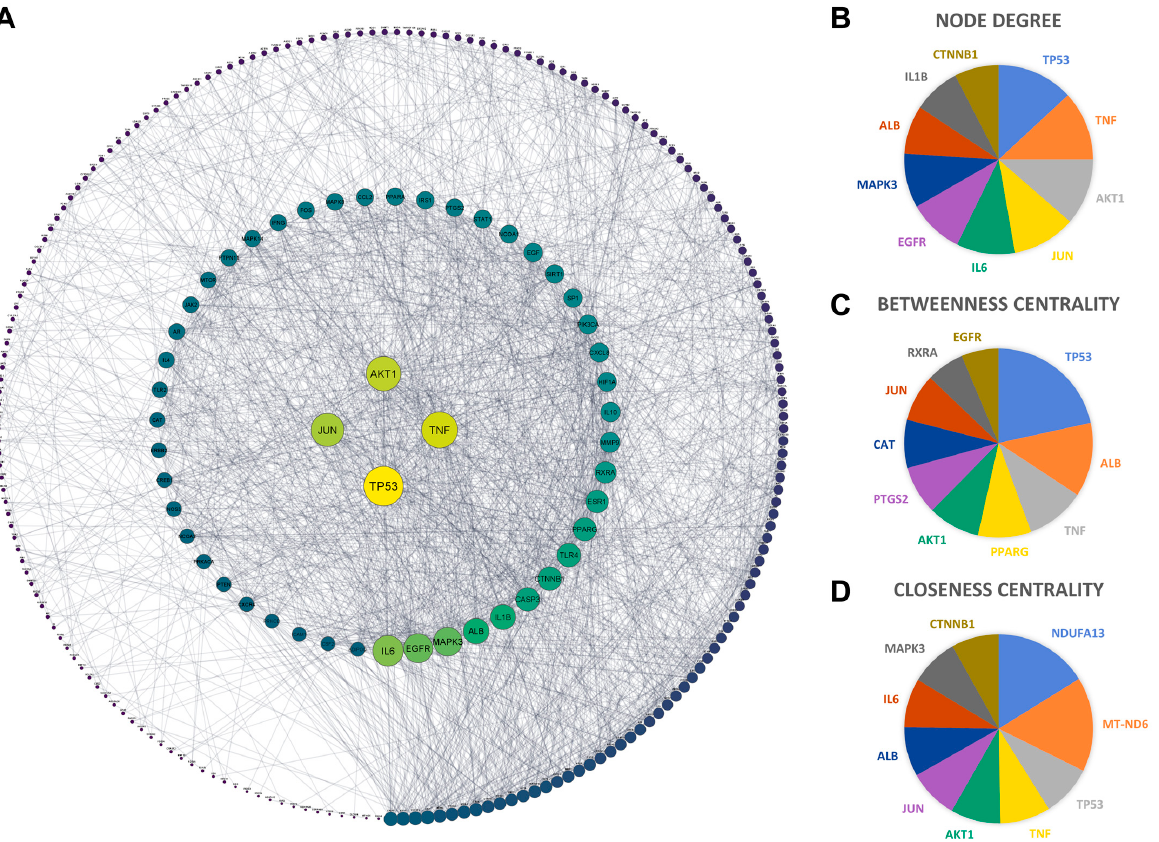
Figure 5. ( A ) Protein–protein interaction network of Aloe vera –NASH common targets. Nodes and edges represent the targets of Aloe vera against NASH and their interactions. Node size and color reflect degree value; the lower the degree value, the darker and smaller the node. Edge thickness represents the combined score from the STRING database. ( B – D ) Pie charts showing the top 10 genes with the highest values of ( B ) node degree, ( C ) betweenness centrality, and ( D ) closeness centrality.